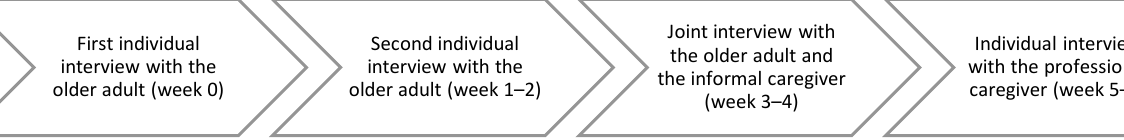
Figure 1. Data collection process.